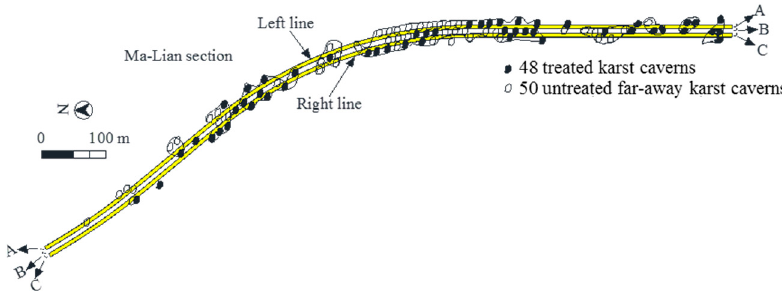
Figure 13. Plane distribution of the karst caverns discovered in the Ma-Lian section